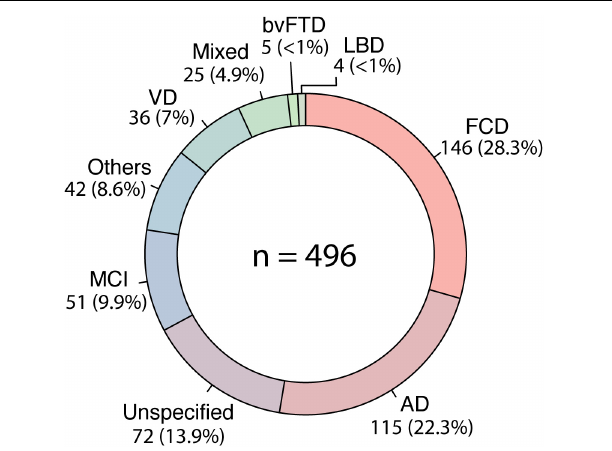
FIGURE 1 | Frequency of diagnosis. The circle represents the frequency of diagnosis in our sample ( n = 516), from 2014 to 2020. FCD, functional cognitive disorder; AD, Alzheimer ’s disease; MCI, mild cognitive impairment; VD, vascular dementia; bvFTD, behavioral variant frontotemporal dementia; LBD, lewy bodies